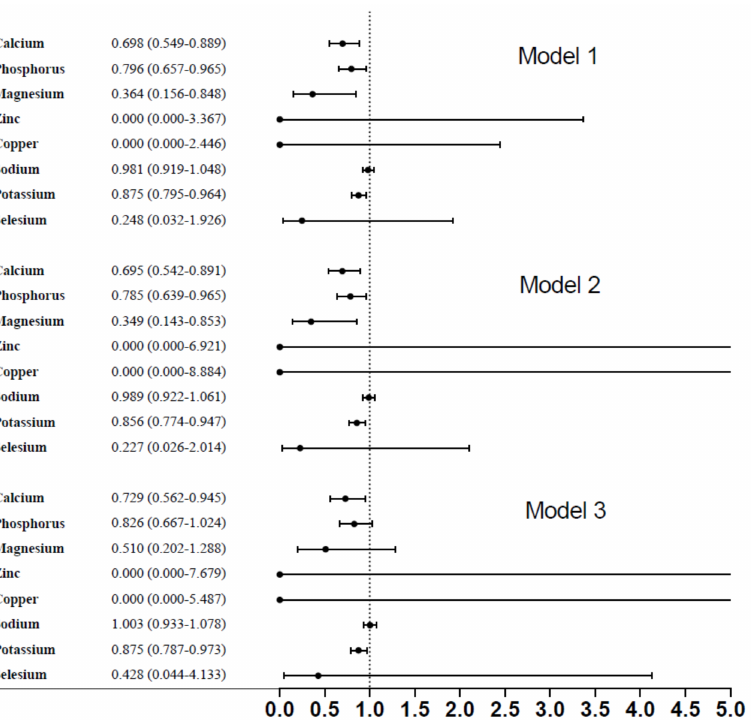
Figure 2. Association between dietary micronutrients and diabetic retinopathy.